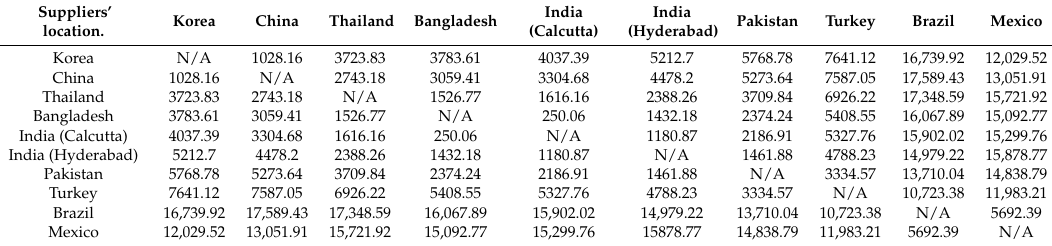
Table 4. The distance between suppliers